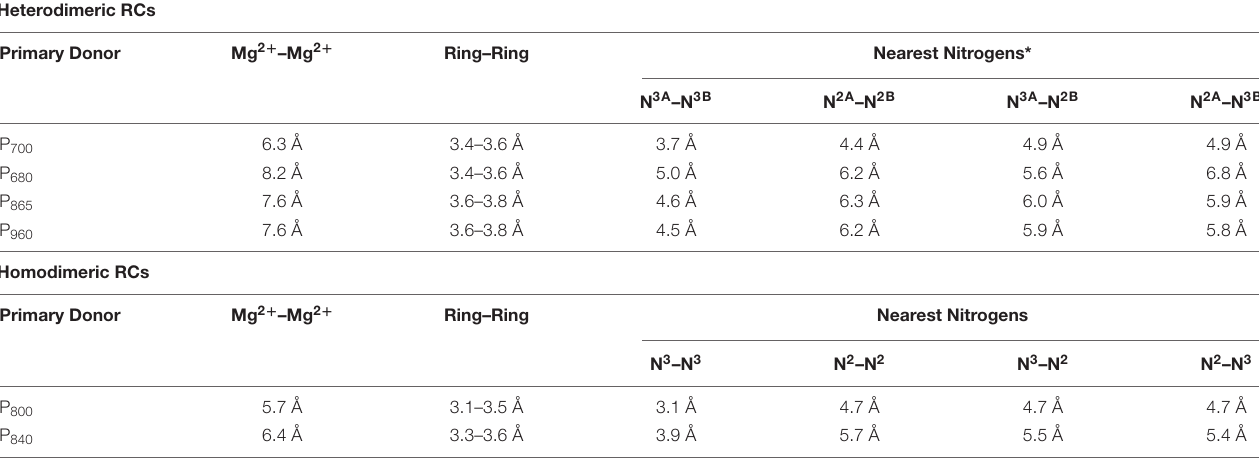
TABLE 1 | Distance parameters of the primary donors of heterodimeric and homodimeric RCs. Heterodimeric RCs Primary Donor Mg 2 + –Mg 2 +